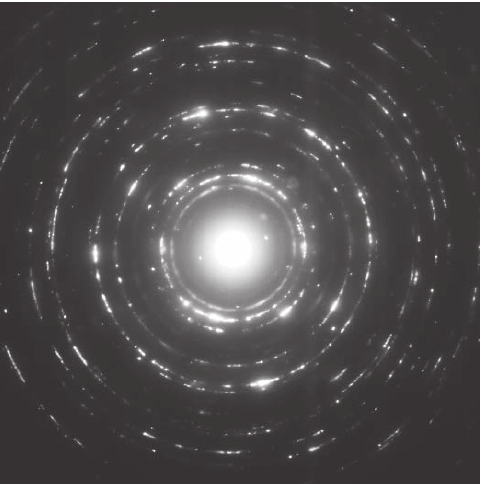
Fig. 1: TEM micrograph of Glidcop after ECAP. Arrows point to several of intragranular Al 2 O 3 particles. Their typical size was ~10 nm. The size of Cu grains was 100–220 nm.